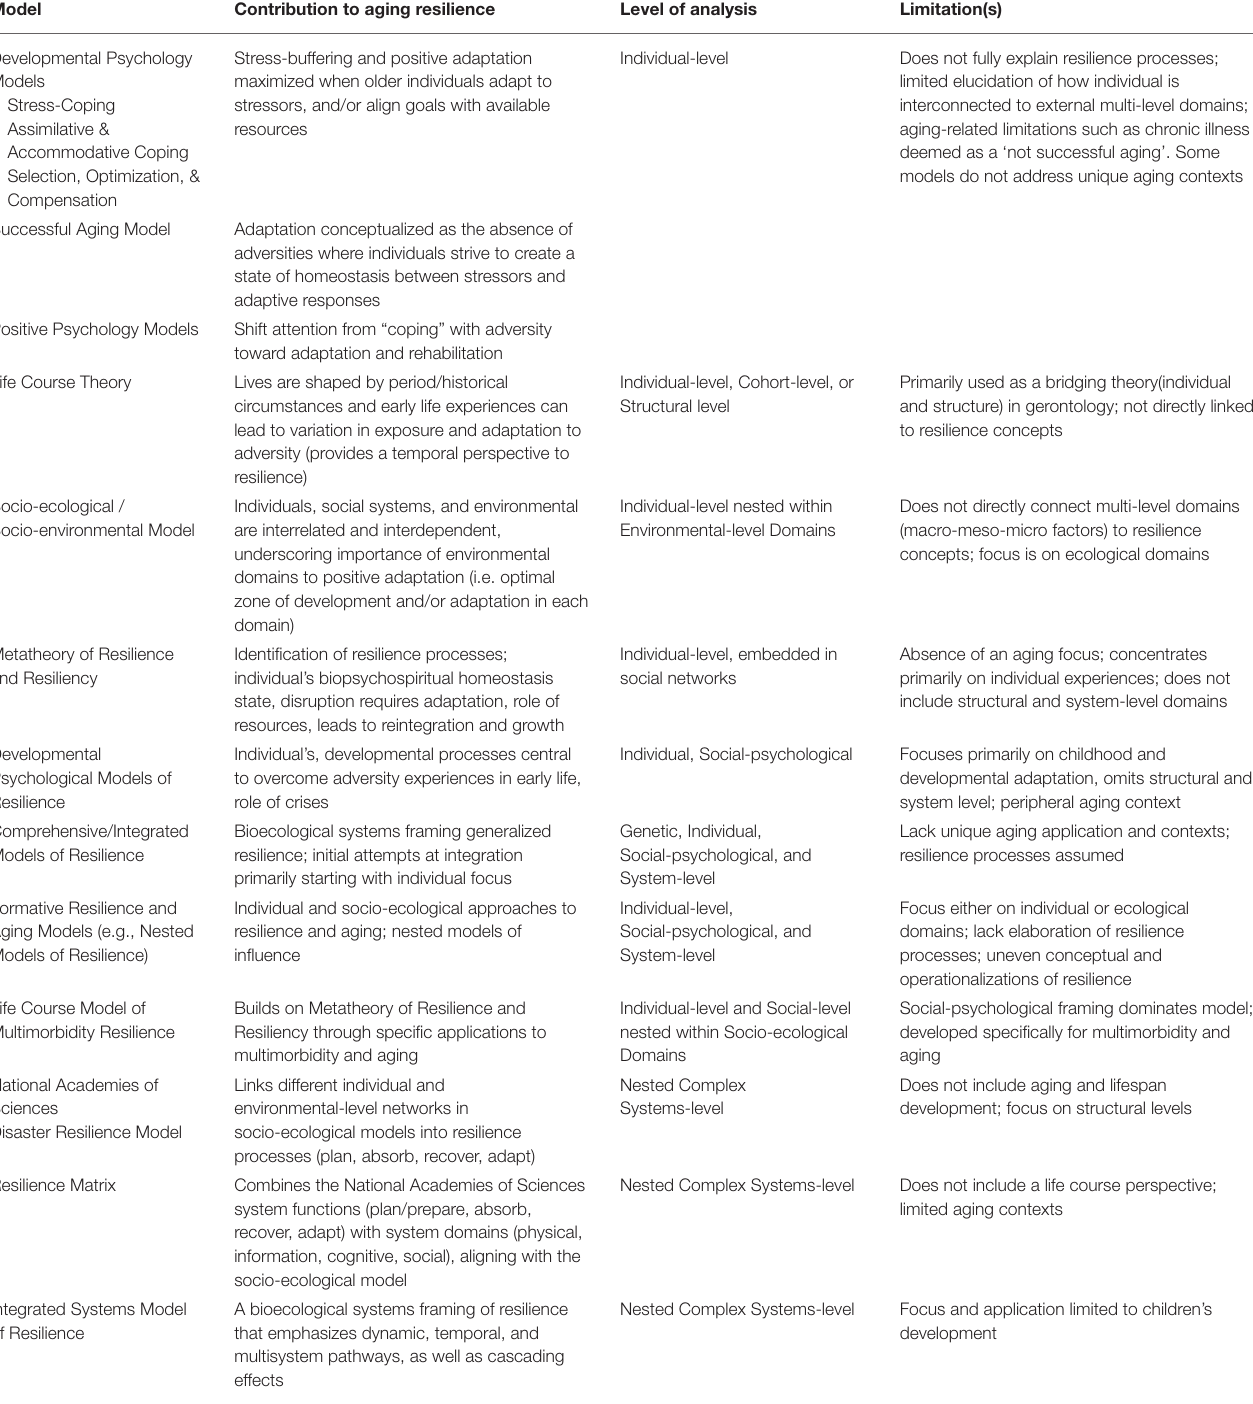
TABLE 1 | Foundational gerontology theories and resilience and aging